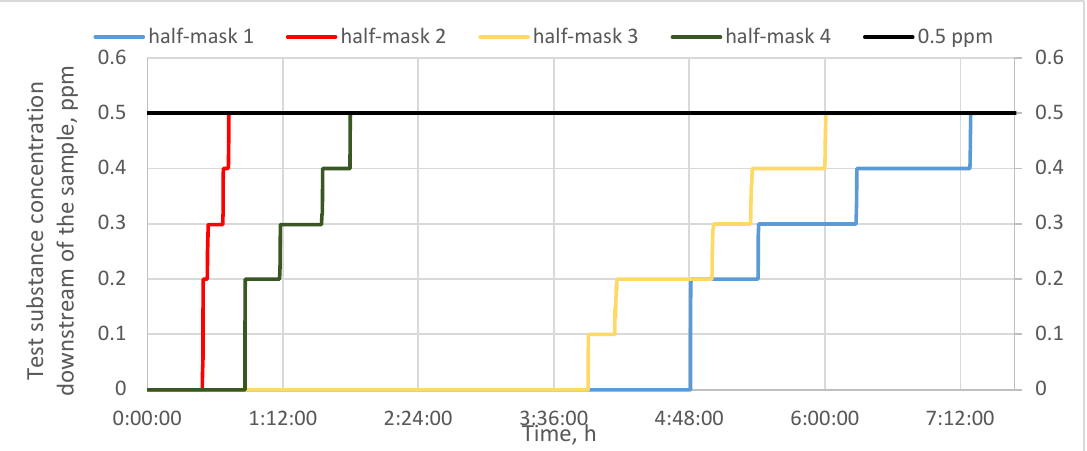
Figure 5. Protection time against sulfur dioxide for half-masks incorporating different types and quantities of carbon sorbents.